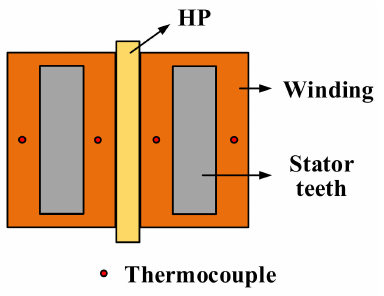
Figure 6. Thermocouples affixation for each slot of the specimen.